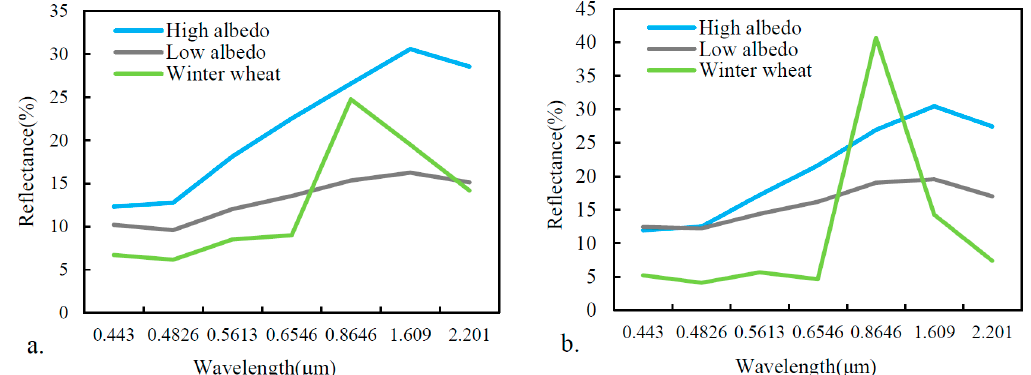
Figure 1. Spectral curves of impervious surfaces and winter wheat in Shijiazhuang from images acquired on ( a ) 1 January 2015 and ( b ) 23 April 2015. High and low albedo are the main types of impervious surfaces. Each curve was plotted using the surface reflectance means of more than 100 pixels.